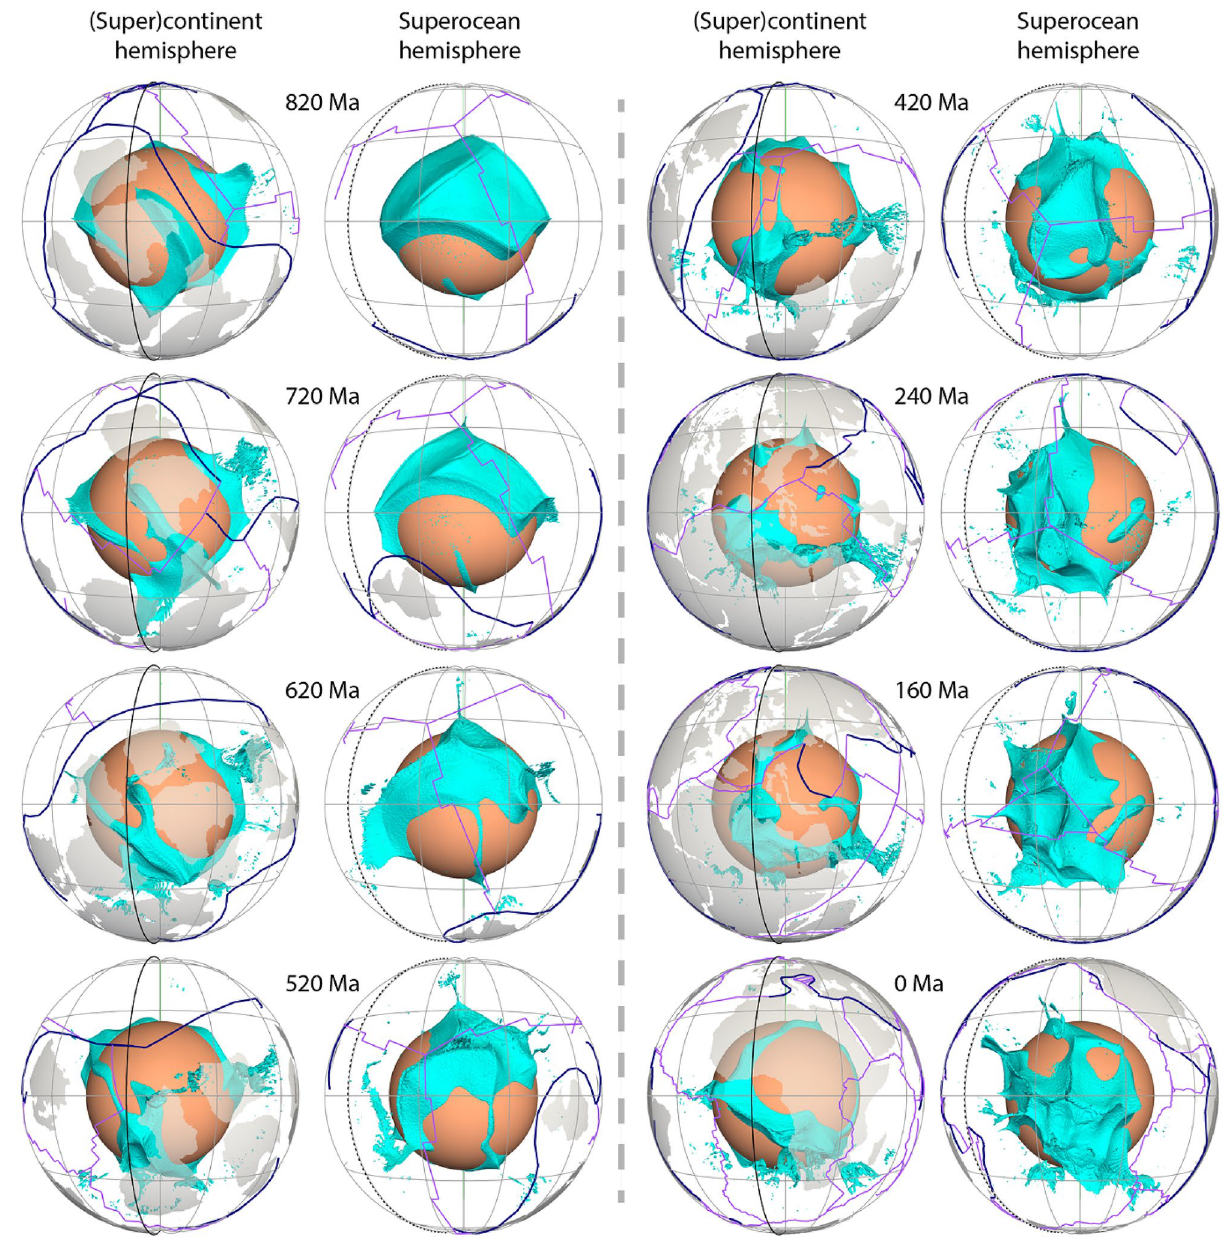
Figure 3. Time-dependent shape of the chemically-distinct basal material (cyan isosurface enclosing mantle consisting of at least 50% dense material) above the CMB. The solid and dashed black meridians are longitudes 0º and 180º, respectively. The view directions for the two hemispheres are the same as in Fig. 2. This figure was created using ParaView version 5.8.1 (https:// www. parav iew. org/) 86